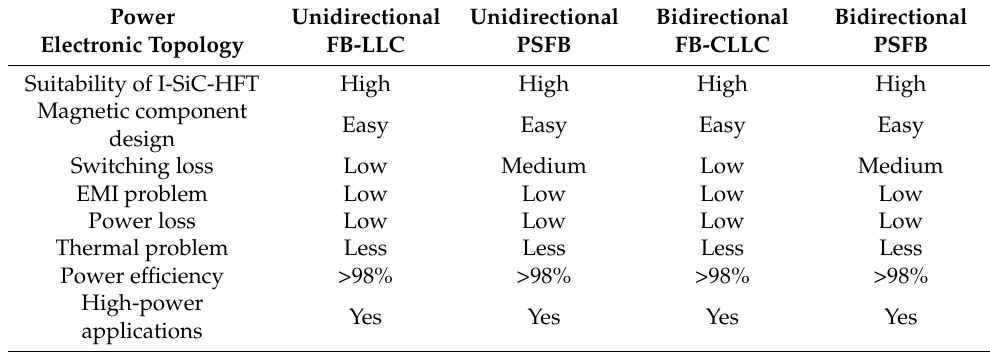
Table 1. Advantages and disadvantages of the HP I-SiC-HFT with different DC–DC converter